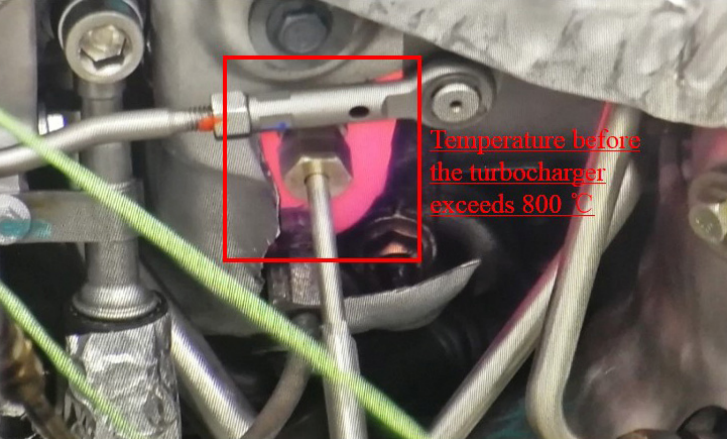
Figure 16. The exhaust pipe under a red hot state.